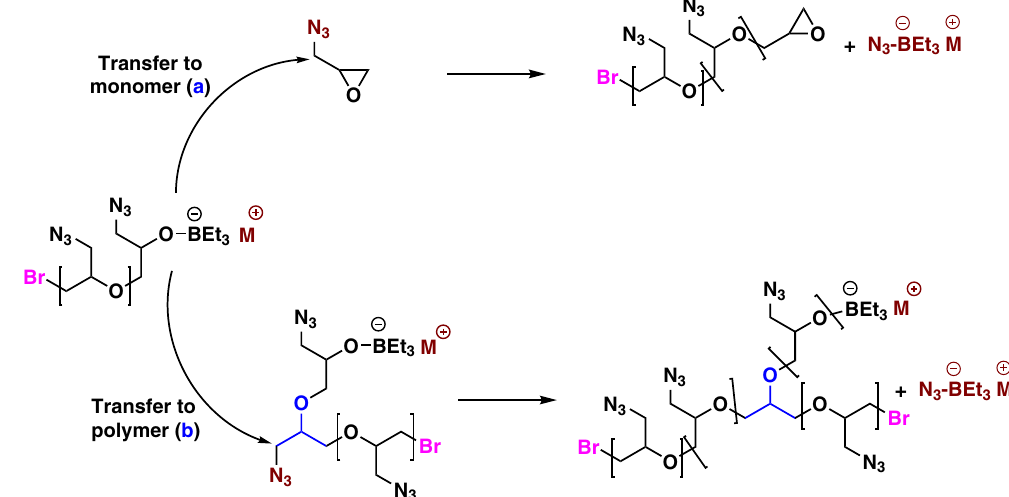
Fig. 4 Transfer reactions occurring during AROP of GA: Path a: transfer reactions occurring by displacement of an azido group from the monomer leading to end groups fi tted with an epoxide (transfer to monomer). Path b: displacement of an azido group from the polymer backbone by a growing alkoxide (transfer to polymer). Both types of transfer reactions result in the formation of branched